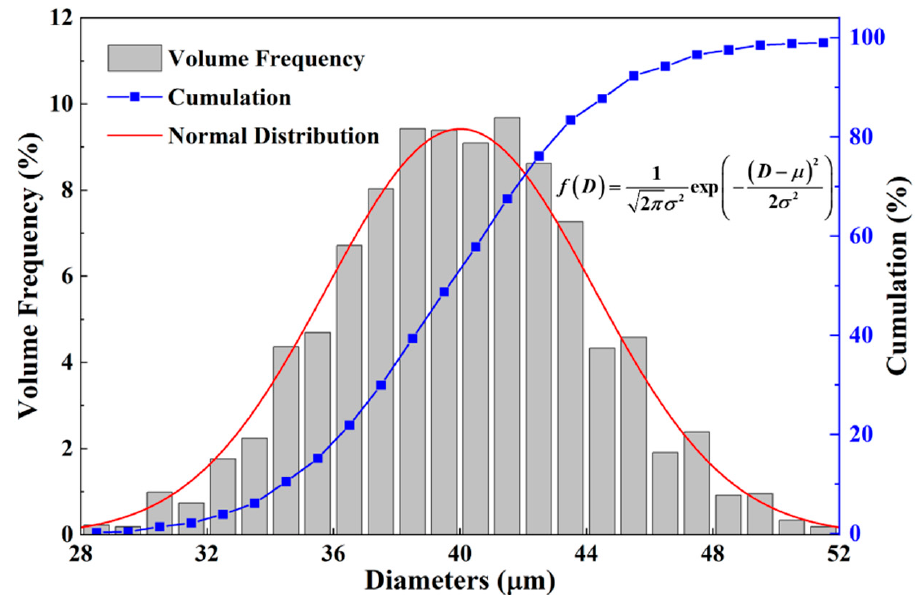
Figure 3. Distribution of aluminum particle diameters.